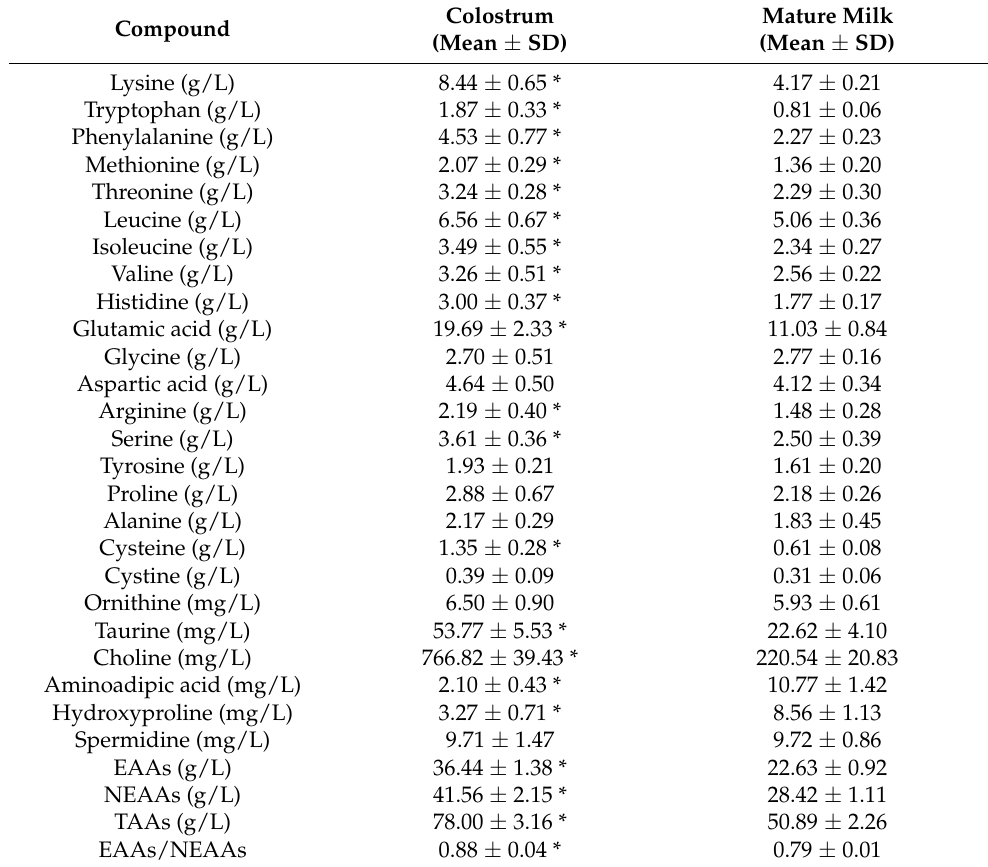
Table 2. The content of amino acids and their derivatives in yak colostrum and mature